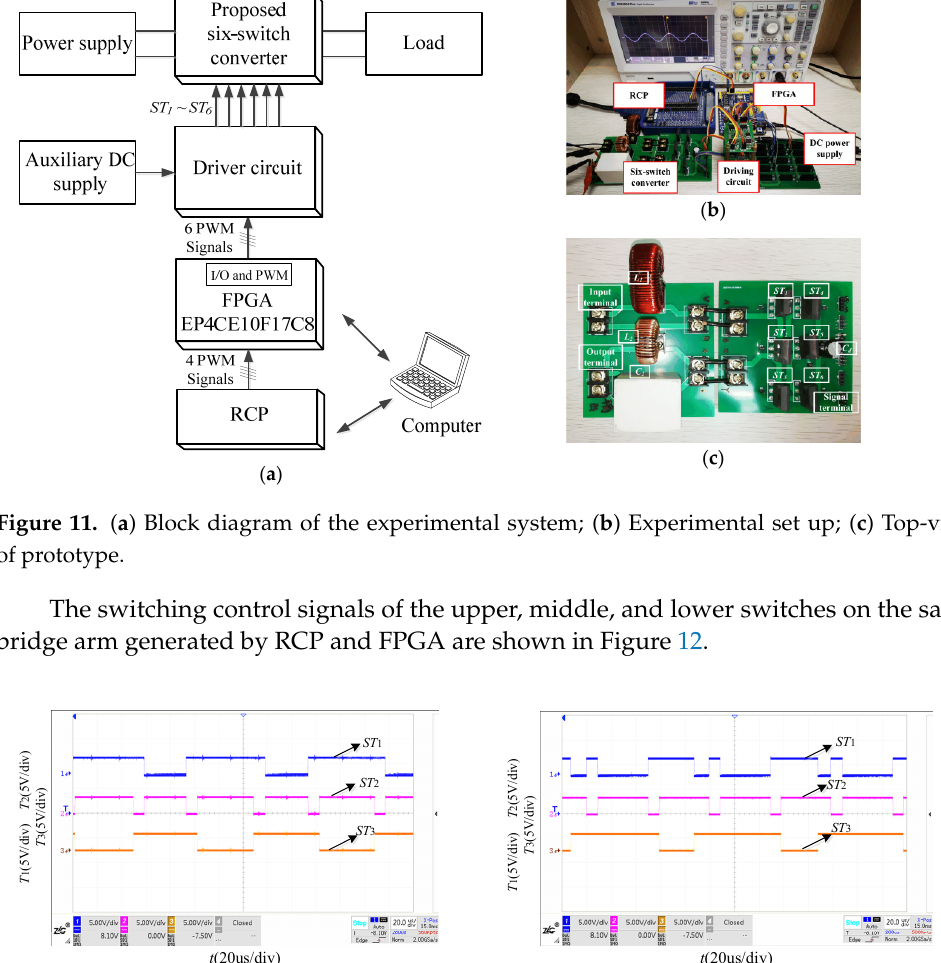
operated in an open loop and the driving signal is generated by RCP and FPGA EP4CE10F17C8.